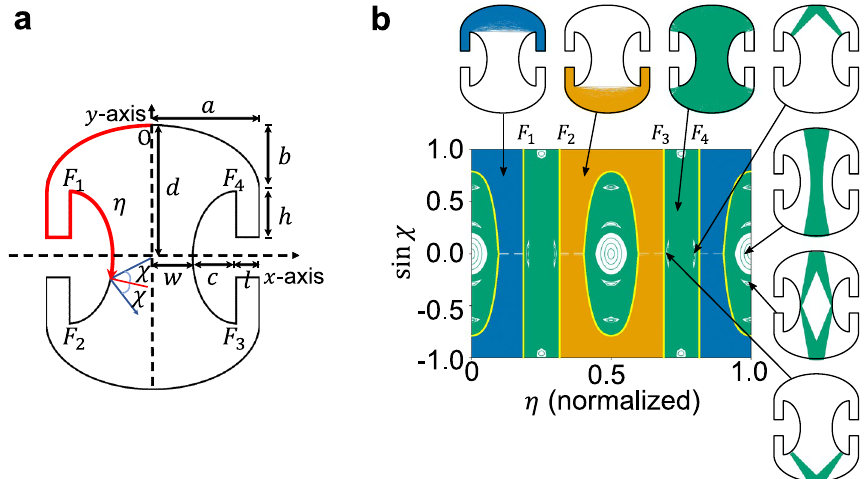
Figure 1. Geometry of the Penrose cavity and its phase space. ( a ) The shape of the Penrose cavity. Arc length η is measured along the circumference from O counter-clockwise. The foci of top and bottom half-ellipses are denoted as F 1 , F 2 , F 3 , and F 4 , respectively. ( b ) There are three divided chaotic regions (colored in orange, green and blue, respectively) in the PSOS of the Penrose cavity. The solid yellow lines mark the boundaries between chaotic regions, and the positions of the foci are labeled on the PSOS. White regions represent island structures. From upper left to the lower right, chaotic orbit in the blue region, chaotic orbit in the orange region, chaotic orbit in the green region, V-shaped orbit in the upper half, axial orbit, diamond orbit and V-shaped orbit in the lower half are shown with arrows indicating the corresponding points on the